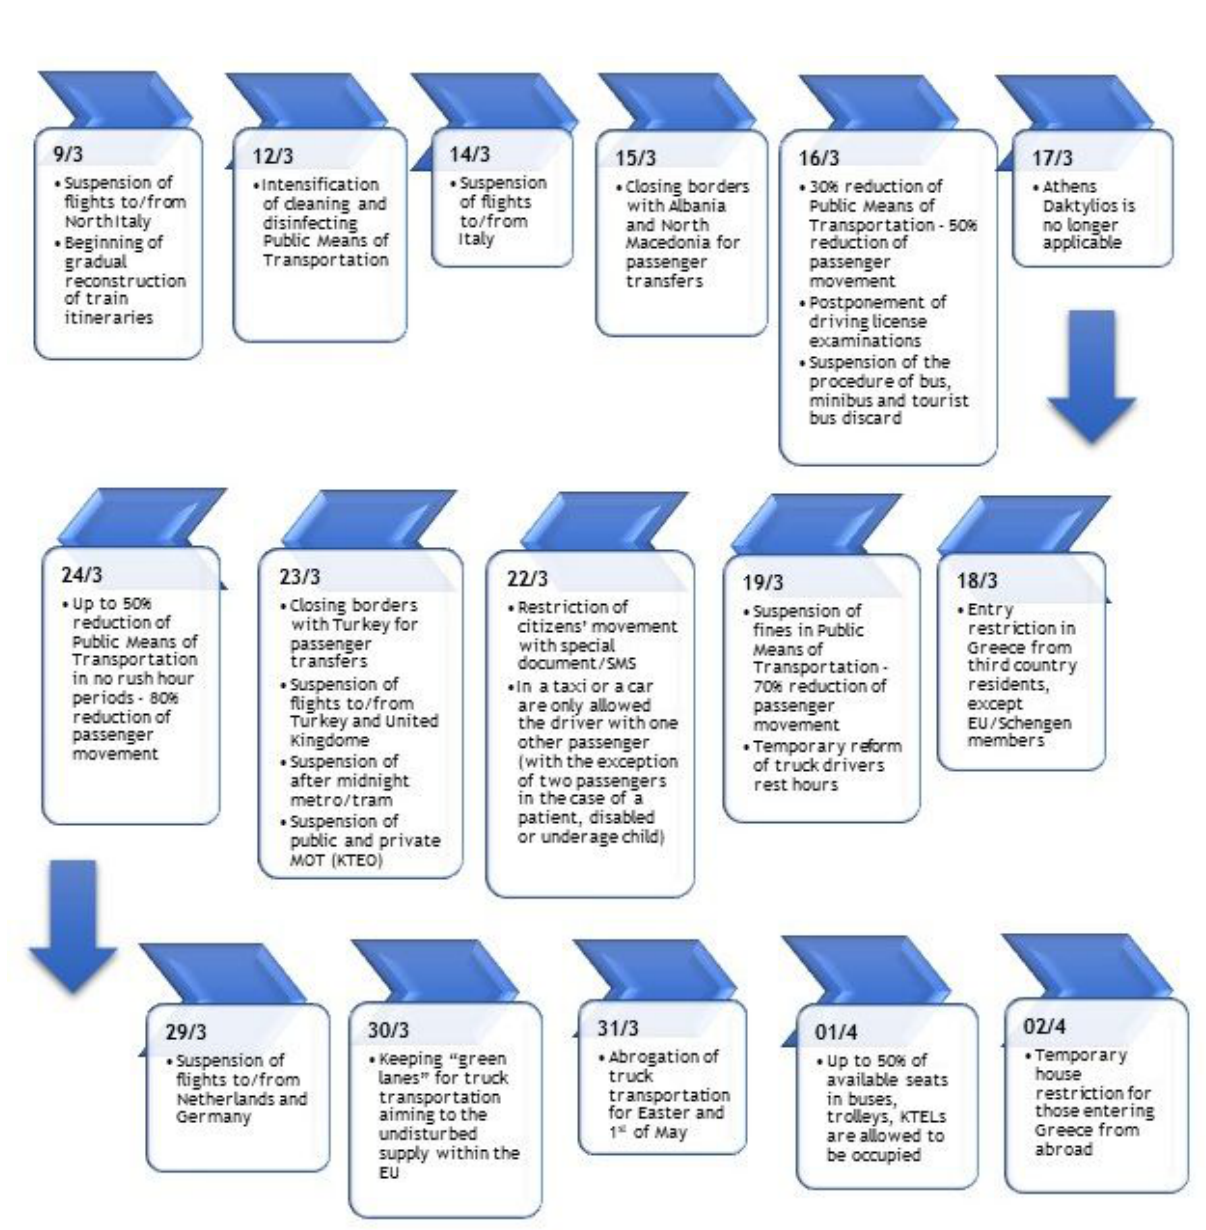
Figure 5: Time history of measures and restrictions enforced in transportation due to COVID-19